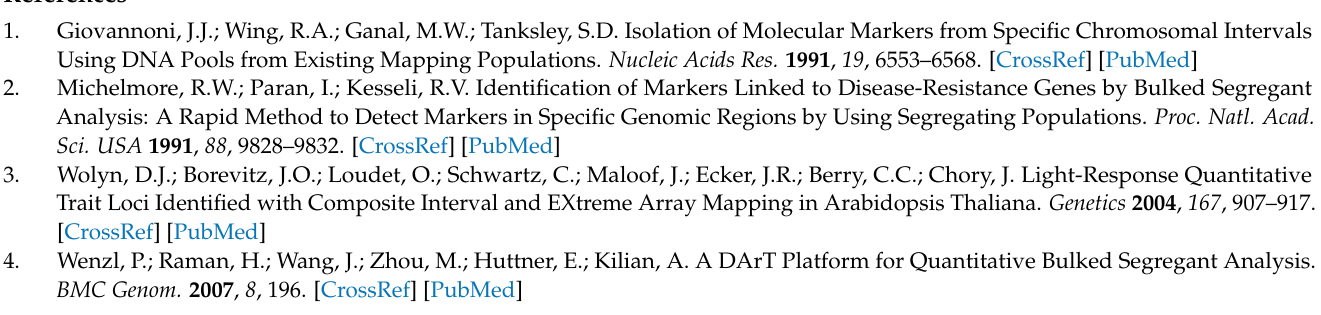
The distribution of unsmooth statistics for example 3 across the whole genome. Supplementary Figure S4: Supplementary Table S1: Description of PNGseqR functions and arguments. Supplementary Table S2. The list of differential expression genes identified in example1. Supplementary Table S3. The gene IDs and GO terms of maize genes in B73 reference genome version 4. Supplementary Table S4. The list of genes in the candidate region on chromosome 8. Supplementary Table S5. QTLs detected for cold-tolerance in a rice RIL population by PNGseqR. Supplementary Table S6. The candidate region for maize small kernel mutant identified by PNGseqR (based on B73 version3 reference genome). Supplementary Table S7. The candidate region for maize small kernel mutant identified by PNGseqR (using 1/5 RNA-seq reads). Supplementary Table S8. The candidate region for maize small kernel mutant identified by PNGseqR (using 1/2 RNA-seq reads). Supplementary